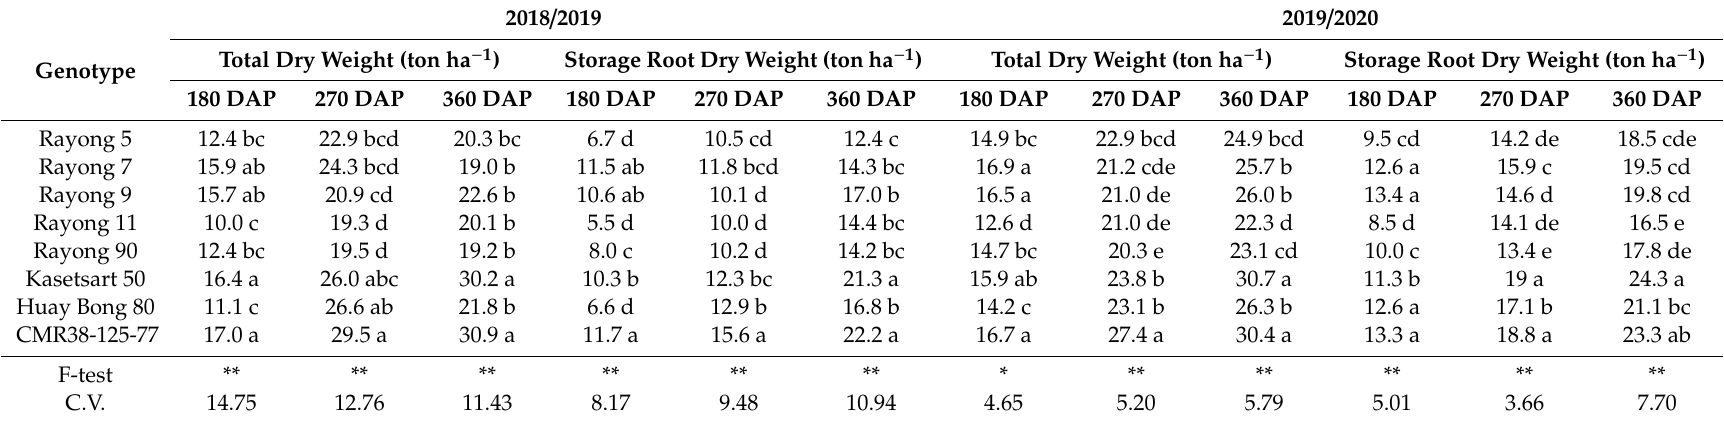
Table 1. Total and storage root dry weights at di ff erent days after planting (DAP) for eight cassava genotypes grown in 2018 / 2019 and 2019 / 2020.